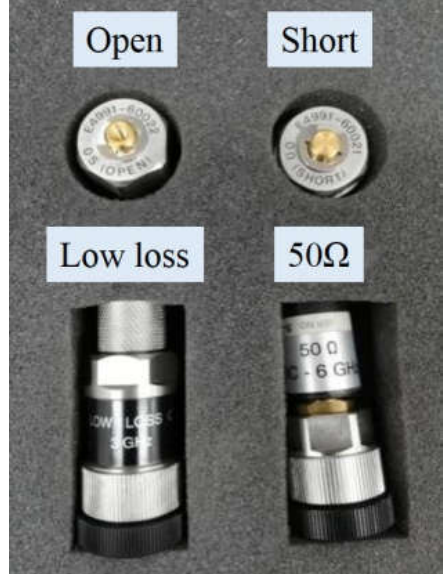
Figure 2. Four standard parts for calibration. Table 2. The technology parameters of the broadband dielectric and impedance spectroscopy.